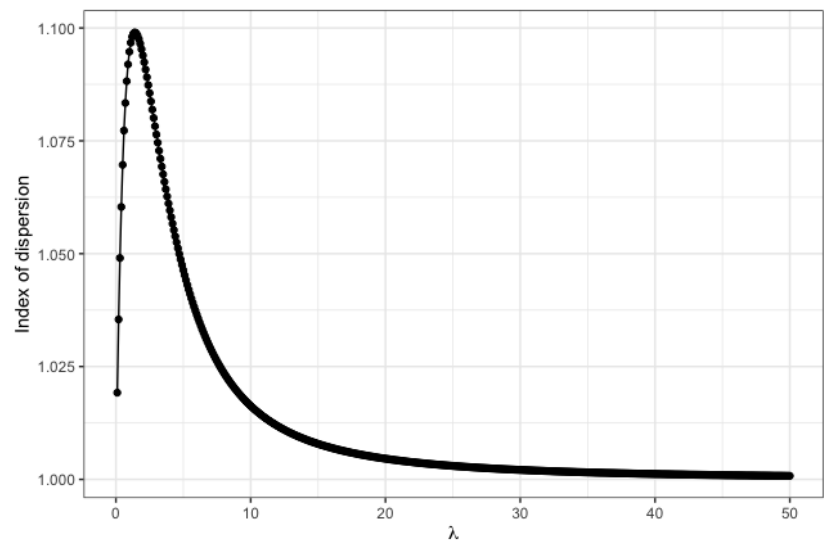
Figure 2. Index of dispersion for different values of λ